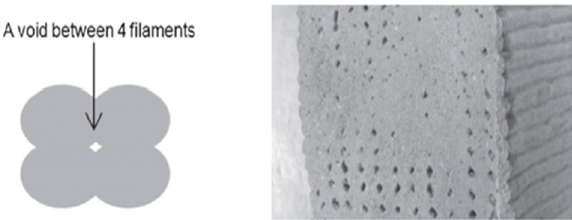
Figure 5. Voids generation in the concrete structure. (Reproduced with permission from: [27], Cement and Concrete Research; published by Science Direct, 2012).